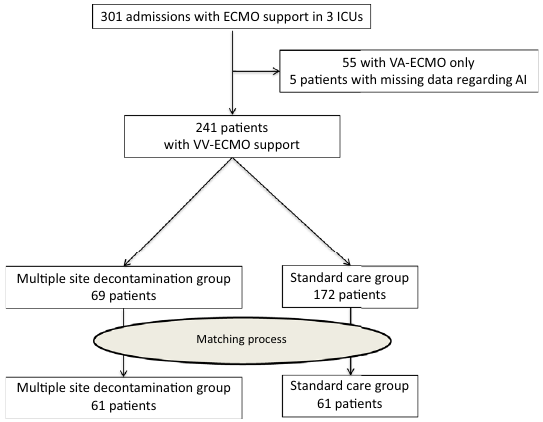
Table 2 Risk factors for ICU acquired infection (Poisson regression)